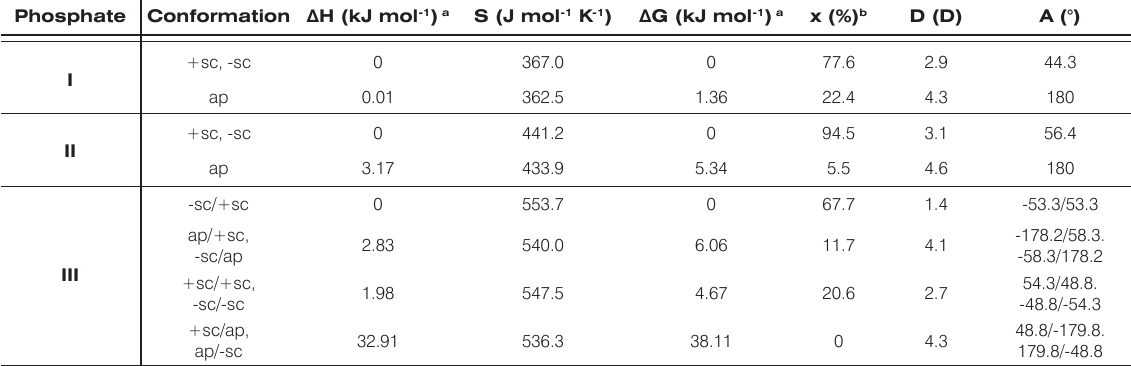
Table 1. Corrected enthalpies ( Δ H), total entropies (S), free Gibbs energies ( Δ G), equilibrium mole fractions (x), dipole moments (D) and optimized values of dihedral angles C–O–P=O (A).